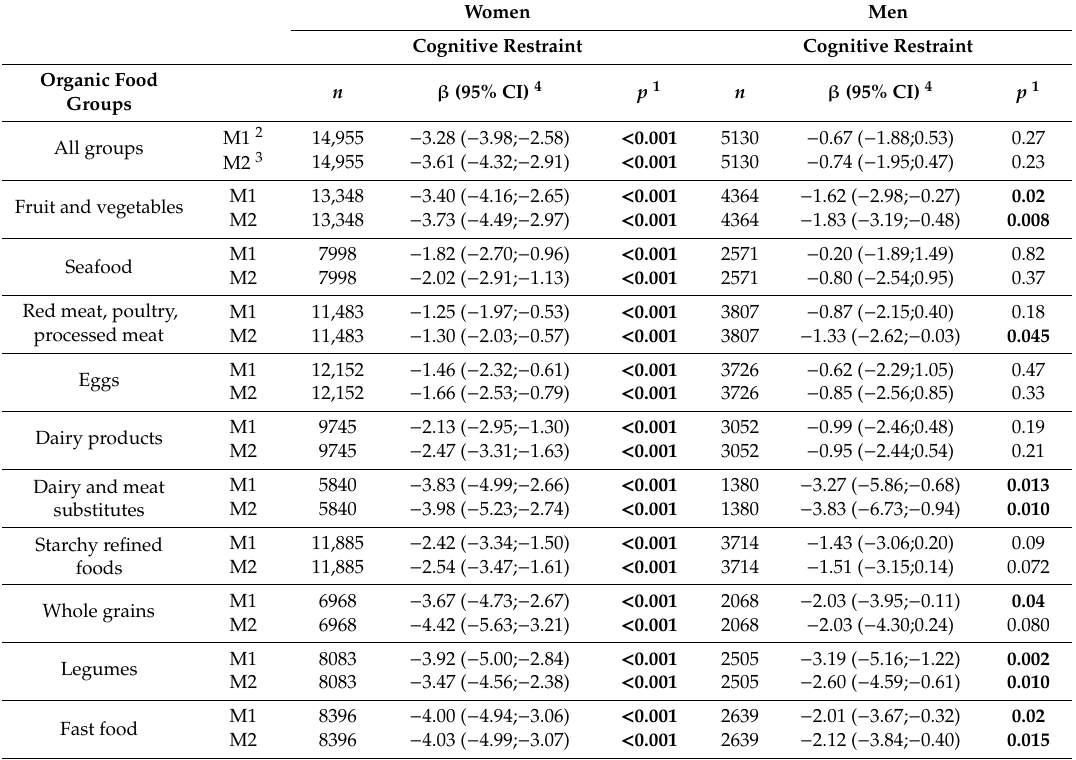
Table 3. Multivariable regression analysis between cognitive restraint score and organic food